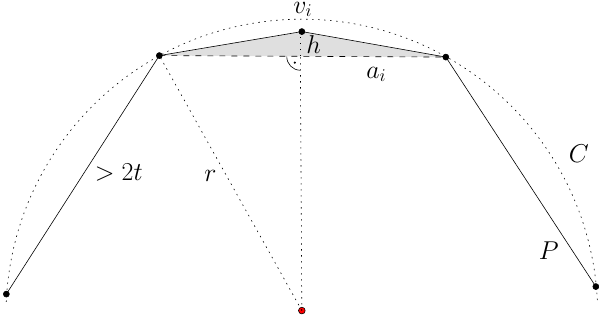
Figure 1. Constructing firefighter instances to show